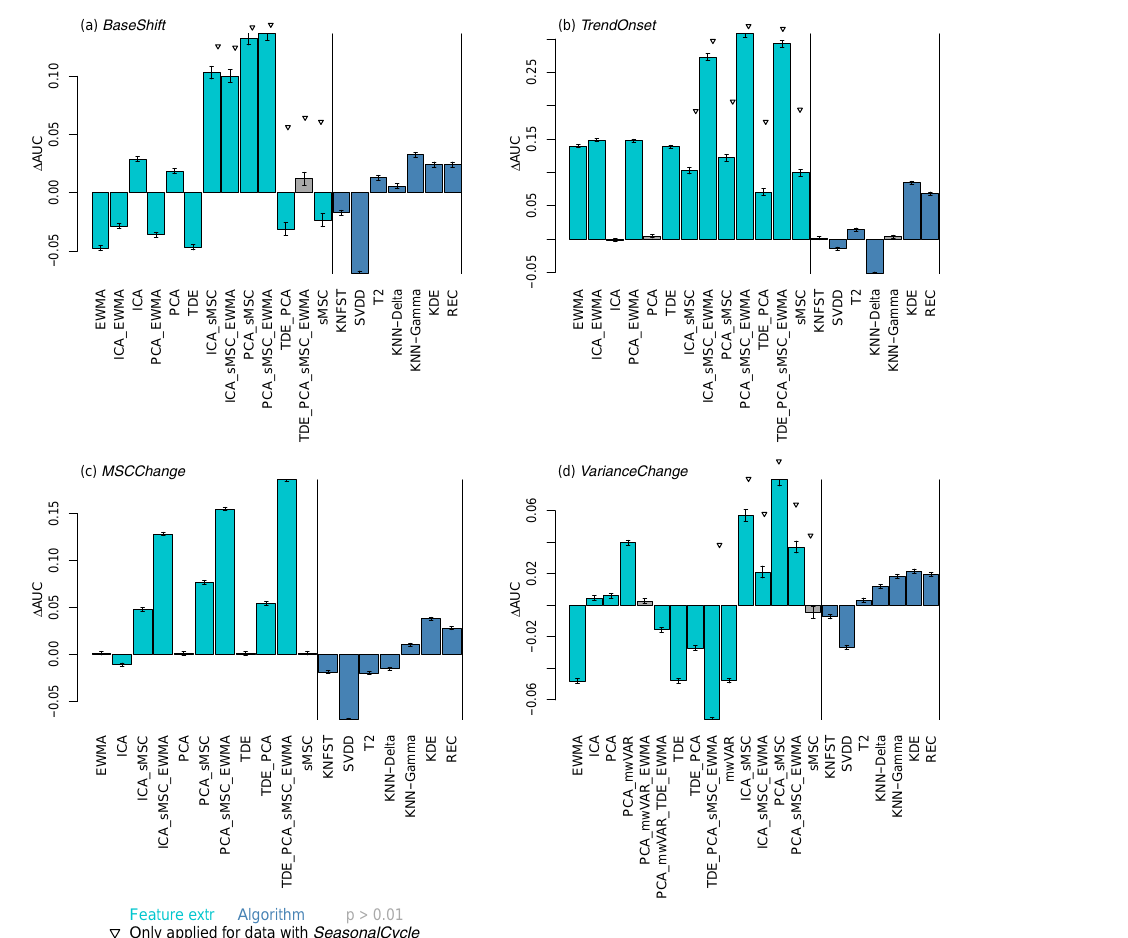
Figure 4. AUC difference with respect to the UNIV control in the experimental factors feature extraction and detection algorithm for the event types (a–d)